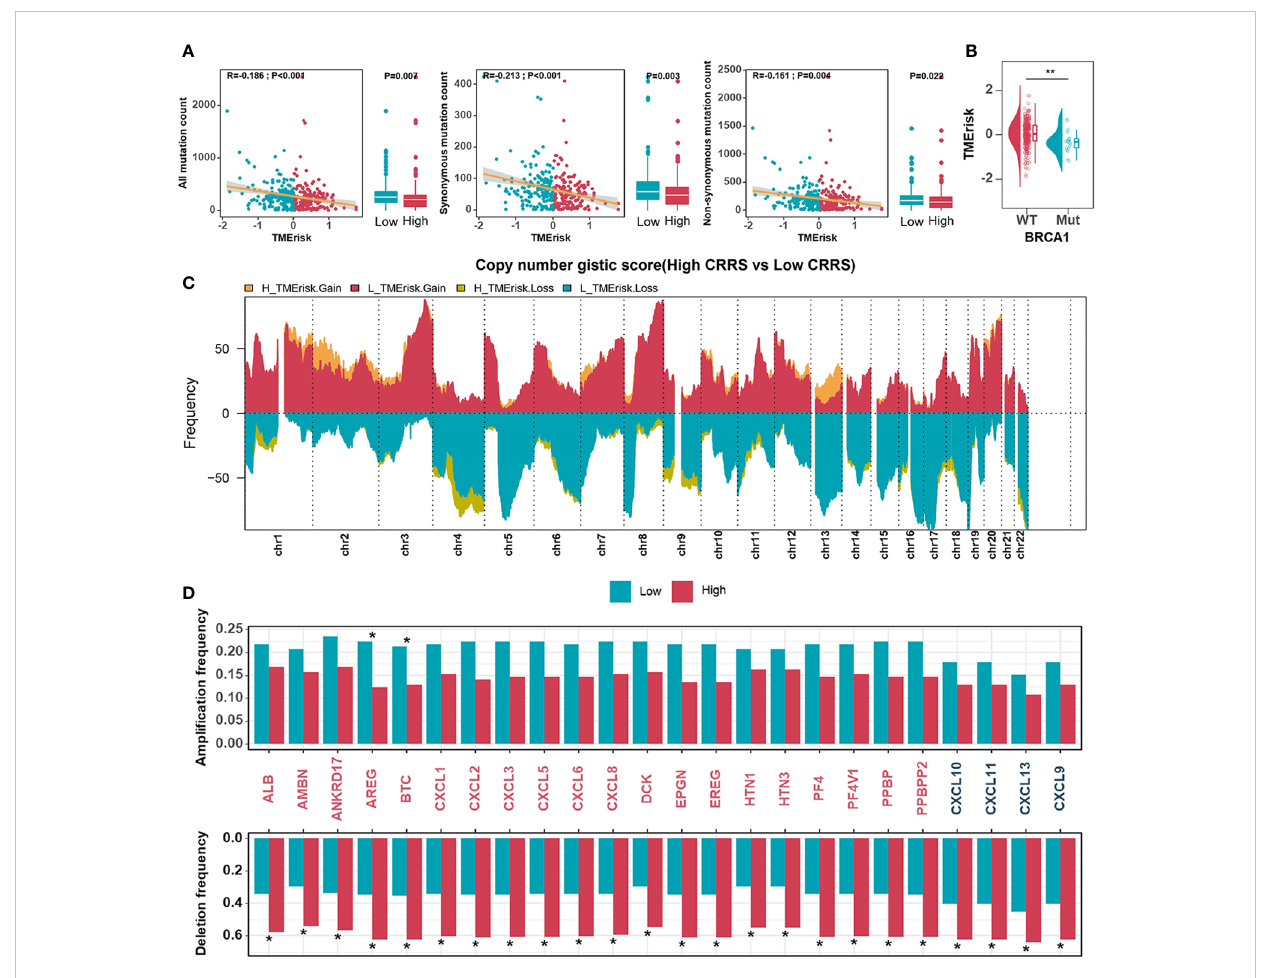
FIGURE 3 Genomic states of different TMErisk groups in HGSOC. (A) Boxplots comparing all mutation counts (left), synonymous mutation counts (middle), and non-synonymous mutation counts (right) between low- and high-TMErisk groups, and the correlation between mutation count and the TMErisk score in TCGA-OV cohort. (B) Distribution of TMErisk scores in the BRCA1 mutant and wild-type groups. (C) Gains and losses in copy numbers in groups with low and high TMErisk. (D) Copy number variations at chromosomal bands 4q13.3 and 4q21.1 between low- and high-TMErisk groups. * P < 0.05; ** P <